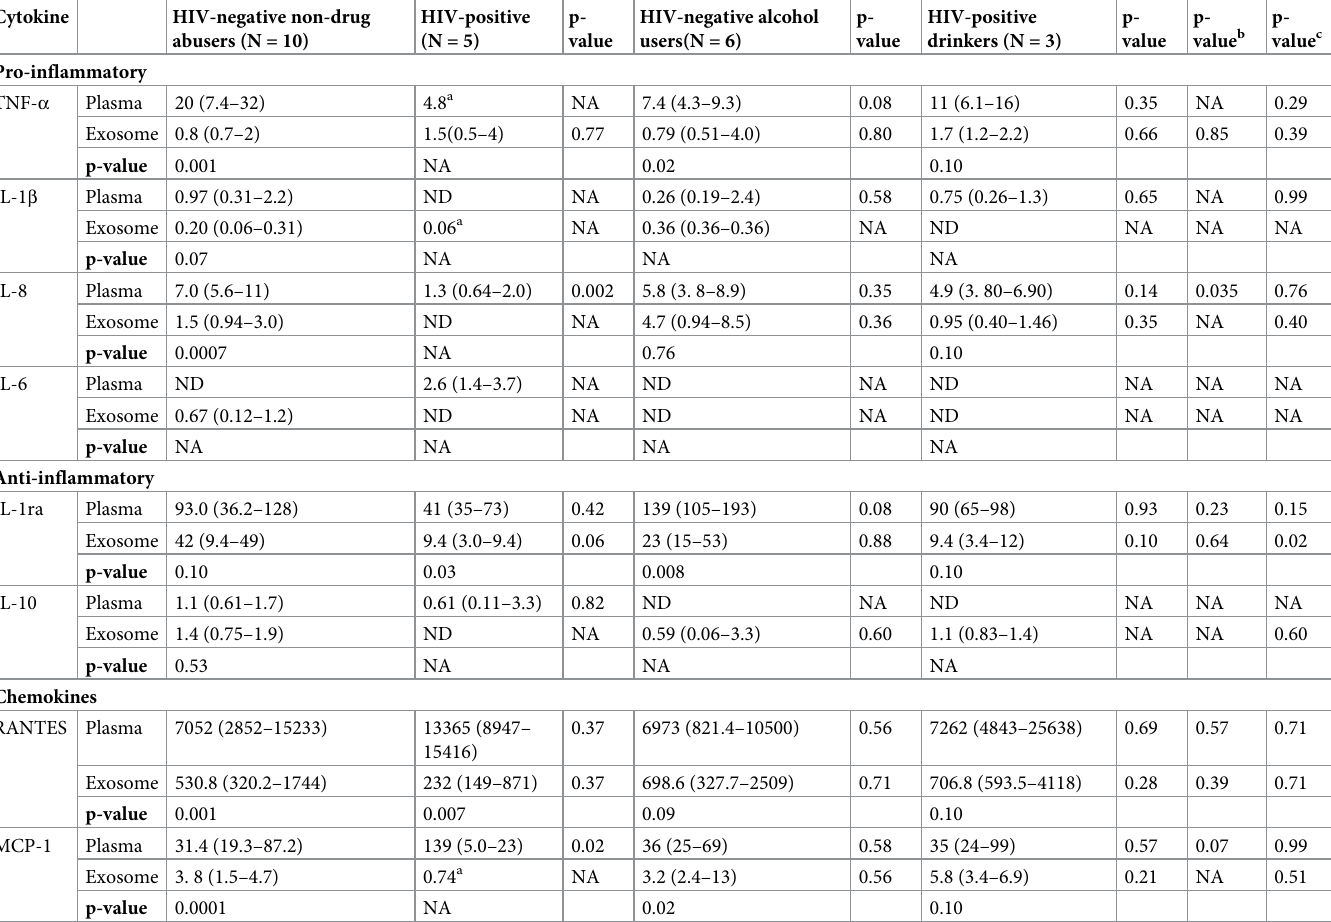
Table 1. Comparison of cytokine and chemokine levels between HIV-negative and-positive alcohol users.